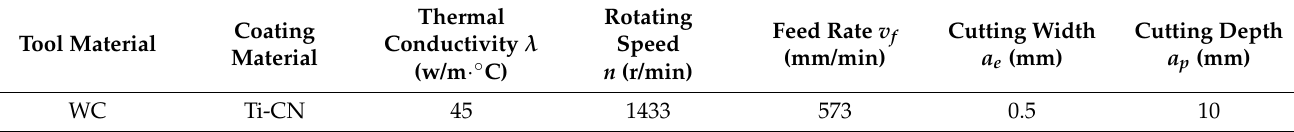
Table 3. Boundary conditions of finite element